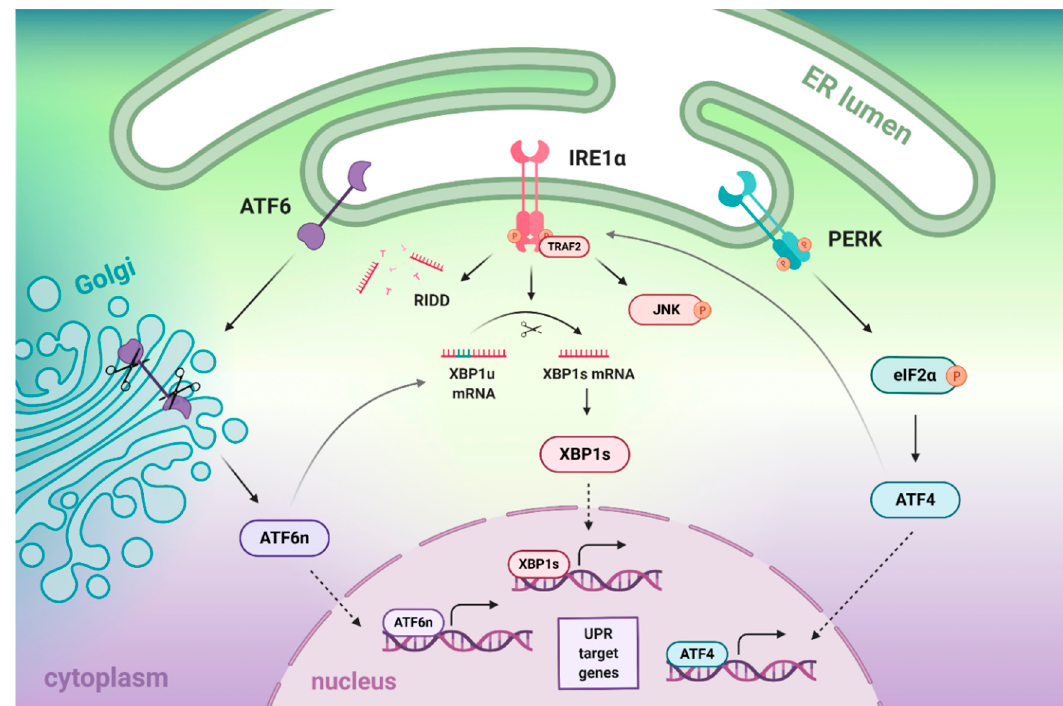
Figure 1. The structure of the Unfolded Protein Response (UPR)-dependent signaling branches and the crosstalk between them. Upon ER stress, the activating transcription factor 6 (ATF6) undergoes proteolytic cleavage in the Golgi apparatus, wherein its transcriptionally active form (ATF6n) is produced. The inositol-requiring enzyme type 1 α (IRE1 α ) possesses several activities: It induces the regulated IRE1-Dependent Decay (RIDD) of specific mRNAs, the unconventional splicing of x-box binding protein 1 ( XBP1) mRNA, as well as it interacts with the TNF Receptor Associated Factor 2 (TRAF2) to initiate the c-Jun N-terminal kinase (JNK) signaling cascade. Activated protein kinase R (PKR)-like endoplasmic reticulum kinase (PERK) phosphorylates the eukaryotic initiation factor 2 α (eIF2 α ), which blocks general translation initiation and selectively induces translation of particular mRNAs at the same time, including activating transcription factor 4 (ATF4). The downstream targets of all UPR branches, namely ATF6n, ATF4, and the spliced form of XBP1 (XBP1s), translocate to the nucleus to regulate the transcription of UPR target genes. Additionally, both ATF6n and ATF4 upregulate IRE1 α activity, via induction of XBP1 mRNA and increase in IRE1 α expression, respectively.